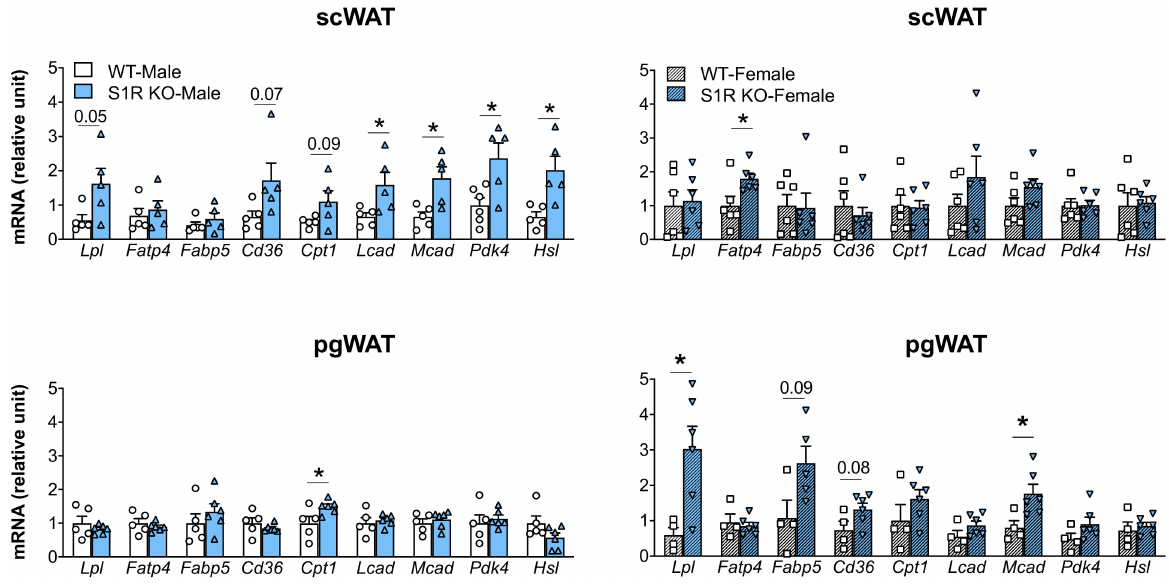
Figure 5. Effect of S1R ablation on the expression of genes involved in lipid metabolism and adipoge- nesis. Samples were collected from animals that were euthanized at the end point of 12 weeks after HFD feeding. Statistical analysis: Multiple t -test (* p < 0.05), S1R KO vs. WT, n = 5 or 6 mice. Each dot (data point, please see the circle, triangle, and square symbols) on the plots represents the relative gene-expression value for each individual animal. Data are presented as means ± SE.